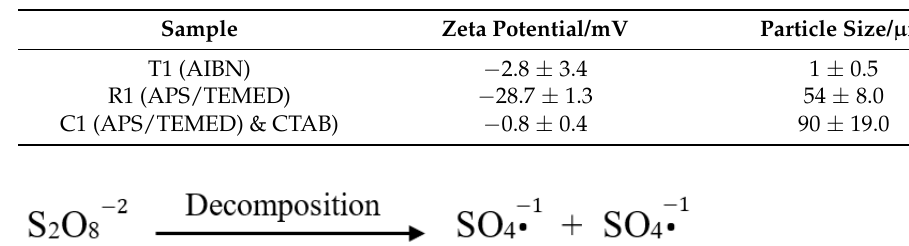
Figure 7. Anionic persulfate radical formation from APS decomposition.